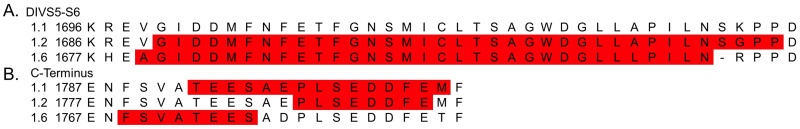
The amino acid sequences for all three channels are shown.These sequences are mapped and aligned to show homologous amino acid pairings. Letters marked in gray represent a lethal region as defined by the cumulative distribution plots. A) The first 41 amino acid bases for the S5-S6DIV linker. B) The first 22 amino acid bases for the C-terminus.